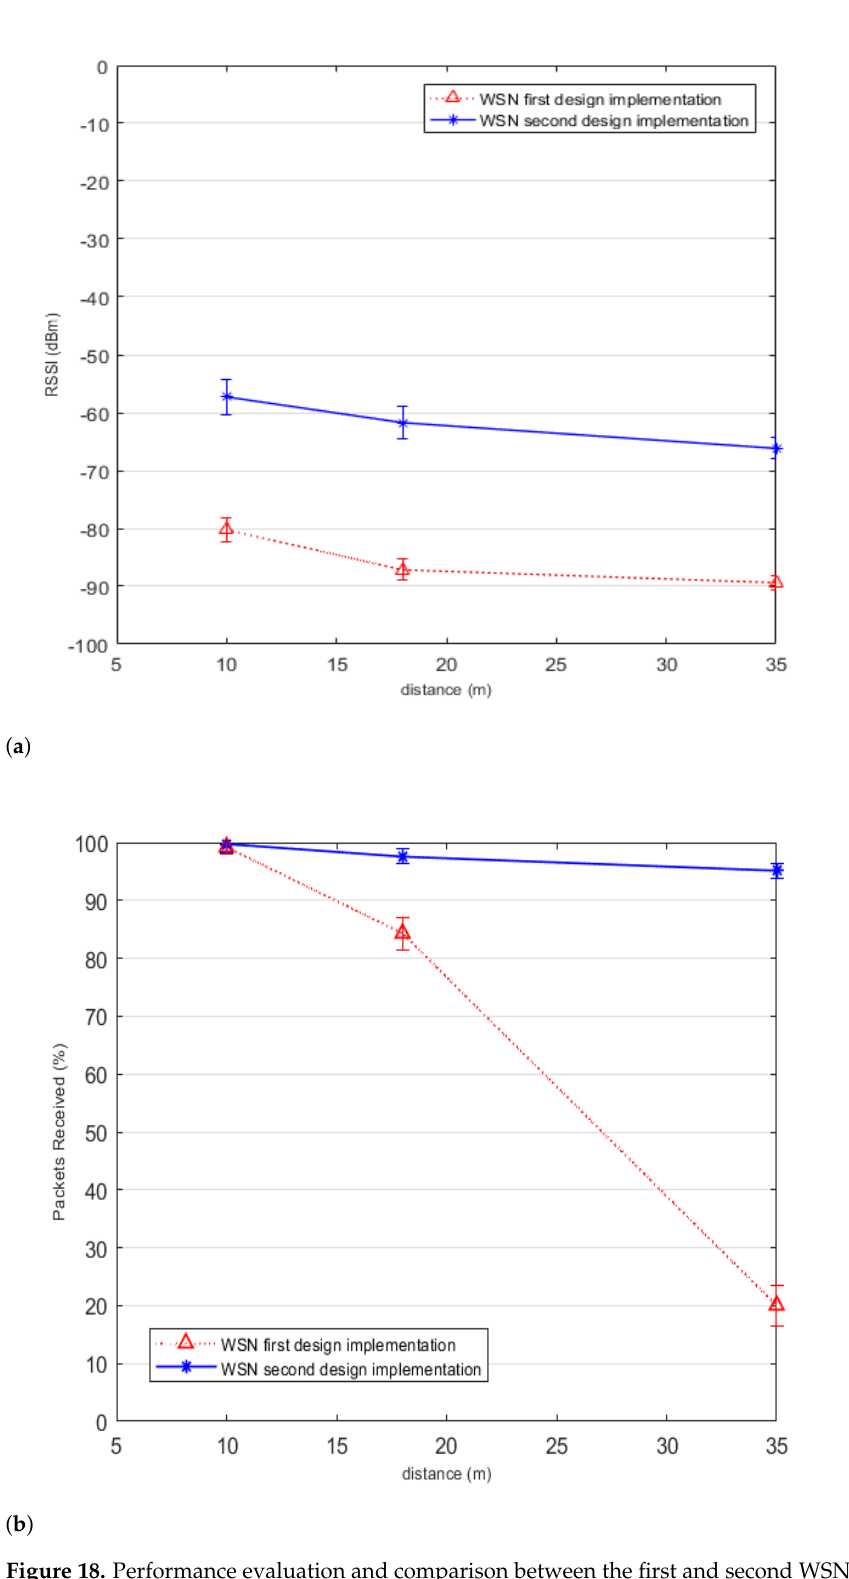
Figure 18. Performance evaluation and comparison between the first and second WSNs implementa- tions for non-line of sight with wall blocked obstacles ( a ) RSSI, ( b ) Packets received